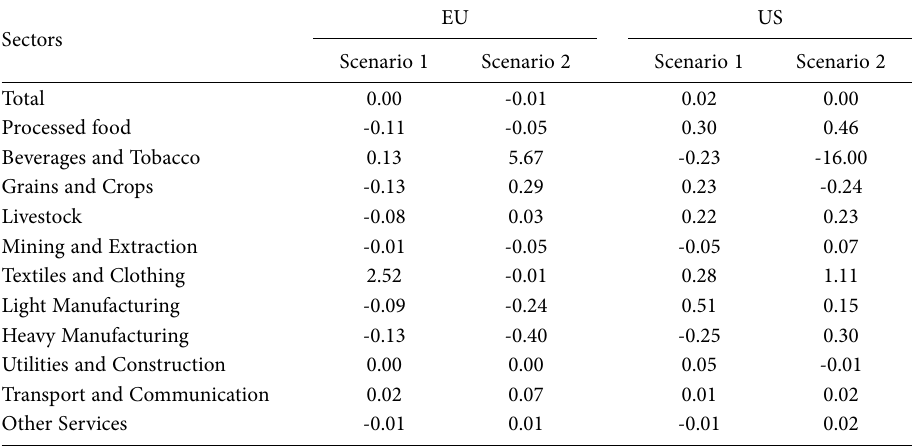
Table 4. Industrial output by sector [%